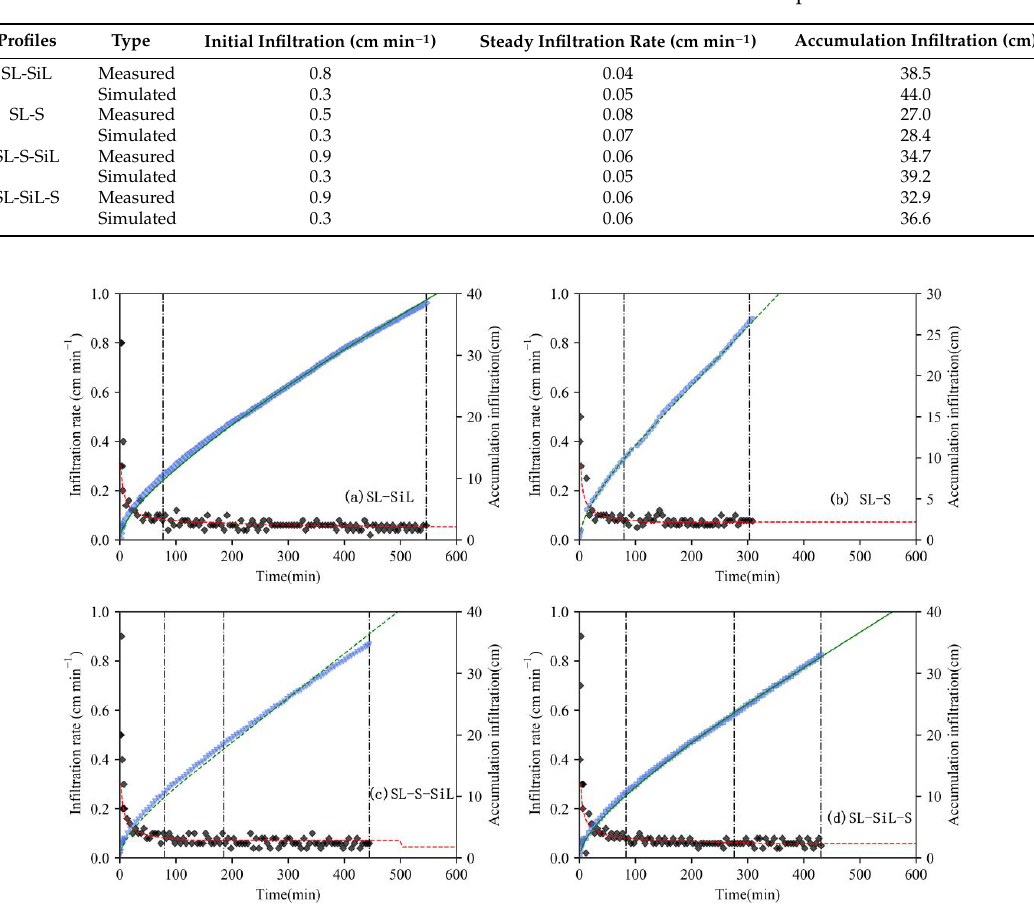
Figure 6. Measured and simulated infiltration rate and accumulation.